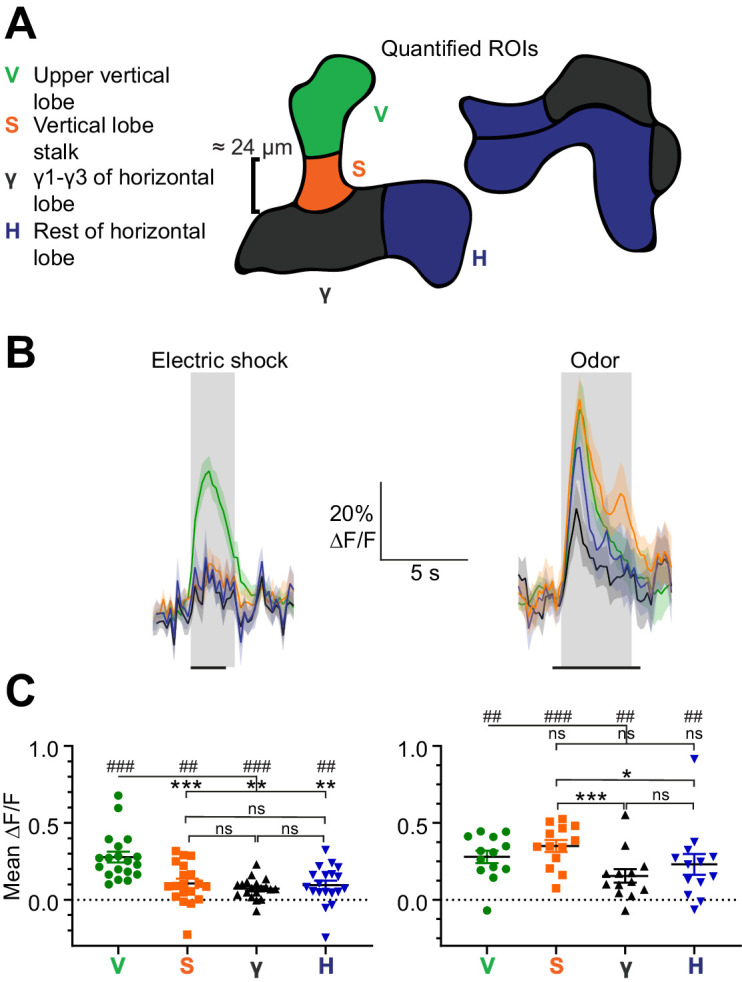
Spatially restricted responses to electric shock in APL.(A) Diagrams of regions used to quantify APL activity in (B–C). (B) APL responses to electric shock (left) or the odor isoamyl acetate (right) in the regions defined in (A), in 474-GAL4 > GCaMP6f flies. Traces show mean ± SEM shading. Electric shock trace is the average of 3 shocks with 12 s between onset of each shock. Horizontal black lines show timing of electric shock (1.2 s) or odor (5 s). (C) Mean ∆F/F during the intervals shaded in panel (B). ## p<0.01, ### p<0.001, one-sample Wilcoxon test vs. null hypothesis (0) with Holm-Bonferroni correction for multiple comparisons. *p<0.05, ***p<0.001, Friedman test with Dunn’s multiple comparisons test for each group (V, H, S, and γ) against each other. n, given as # neurons (# flies): electric shock, 19 (15); odor, 13 (11).Figure 1—source data 1.Source data for Figure 1C.